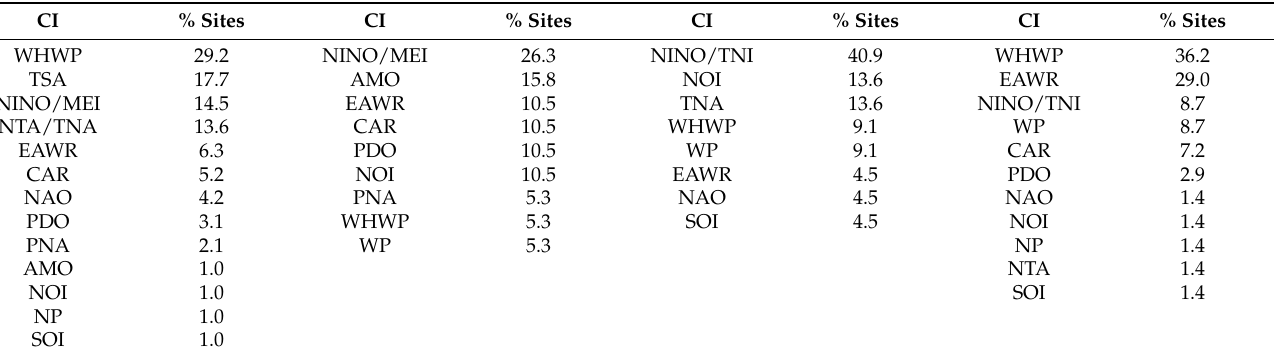
Figure 4. Illustration of CIs resulting in optimal correlation with mean sea level (window size = 60 months; lag = 0) for all sites at which |r| >= 0.60 and p <= 0.05 throughout North America for the full period of record (1948–2018). (See Table 1 for CI abbreviations.). Table 2. Lists of the dominant CIs that correlate with mean sea level and the percent of sites where |r| >= 0.60 and the p -value <= 0.05 using a sliding window size of 60 months and lag time = 0 over the following time periods: 1948–2018 (Columns 1 and 2), 1948–1970 (Columns 3 and 4), 1971–1994 (Columns 5 and 6), and 1995–2018 (Columns 7 and